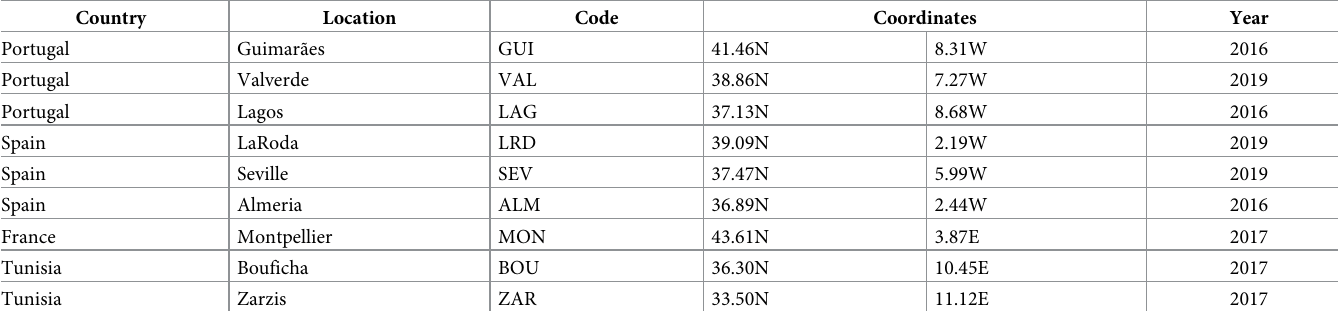
Table 1. Sampling locations and collection year (see acknowledgements for collectors’